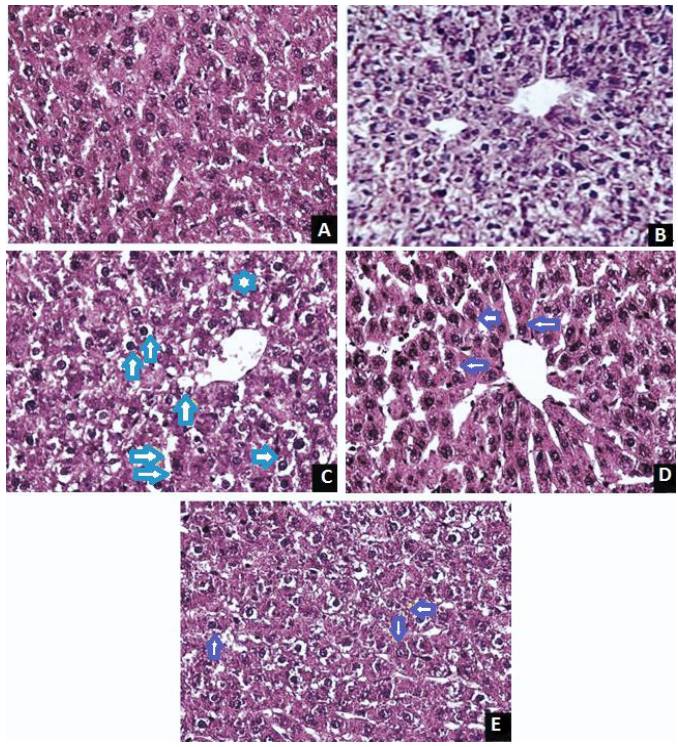
Figure 4. Micrographs showing the effect of Justicia tranquebariensis on TAA-induced hepatic fibrosis in rats. ( A ) Section of normal control rats showing the histological appearance of hepatocytes with prominent nuclei and cytoplasm (H&E. 400 × ); ( B ) Section of J. tranquebariensis (400 mg/kg bw/p.o.) treated control rats showing the histological appearance of hepatocytes with prominent nuclei and cytoplasm (H&E. 400 × ); ( C ) Section of TAA (100 mg/kg bw/s.c.) treated control showing fatty degeneration of some hepatocytes, Kupfer cells characterized by cell swelling, the replacement of the cytoplasm with a clear fluid and a centrally located nucleus ( ↑↑ blue), loss of cell boundaries, hepatic necrosis, collagen and fibronectin deposition and inflammatory cell infiltration (H&E. 400 × ); ( D ) Section of TAA (100 mg/kg bw/s.c.) plus J. tranquebariensis (400 mg/kg bw/p.o.) treated rats showing regenerated cells and the almost normal architecture of the liver ( ↑ violet) with a decrease in collagen and fibronectin deposition (H&E. 400 × ); ( E ) Section of TAA (100 mg/kg bw/s.c.) plus silymarin (50 mg/kg bw)-treated rats showing regenerated cells and the almost normal architecture of the liver ( ↑ violet) with decrease in collagen and fibronectin deposition (H&E. 400 ×